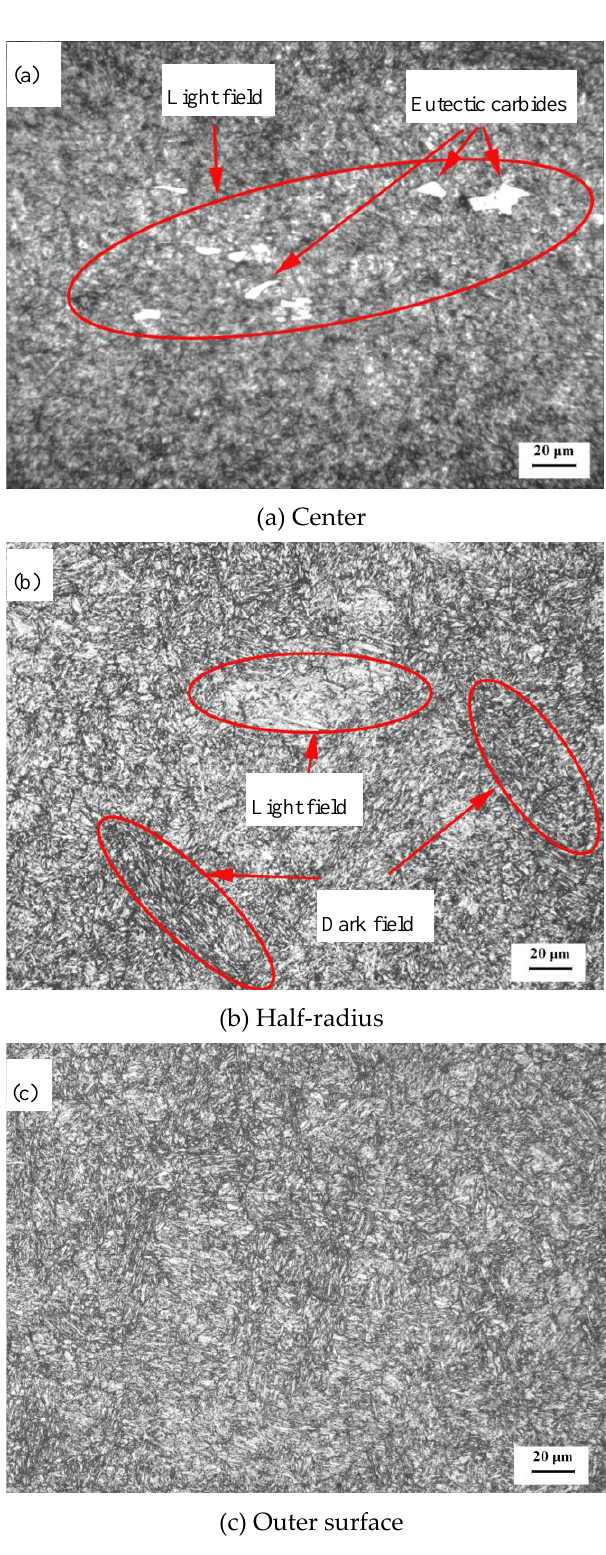
Figure 3. Microstructure of the H13 ingot at different positions after tempering. ( a ) Center; ( b ) Half-radius; ( c ) Outer surface.